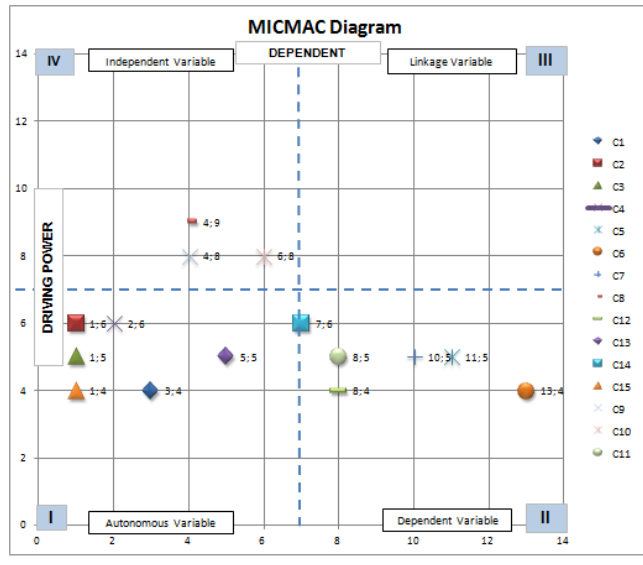
Figure 4. MICMAC diagram analysis